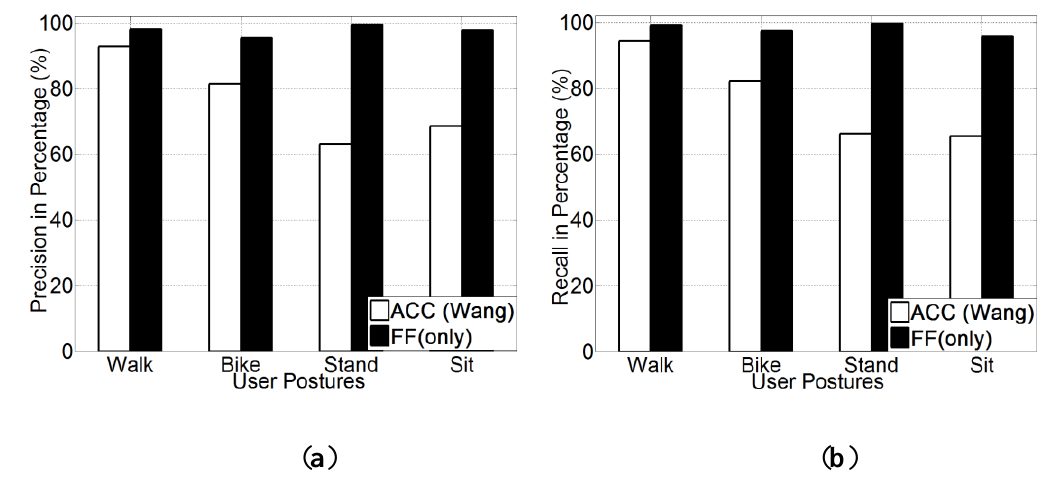
Figure 6. Human posture and mobility recognition results using decision tree: ( a ) precision; ( b ) recall.